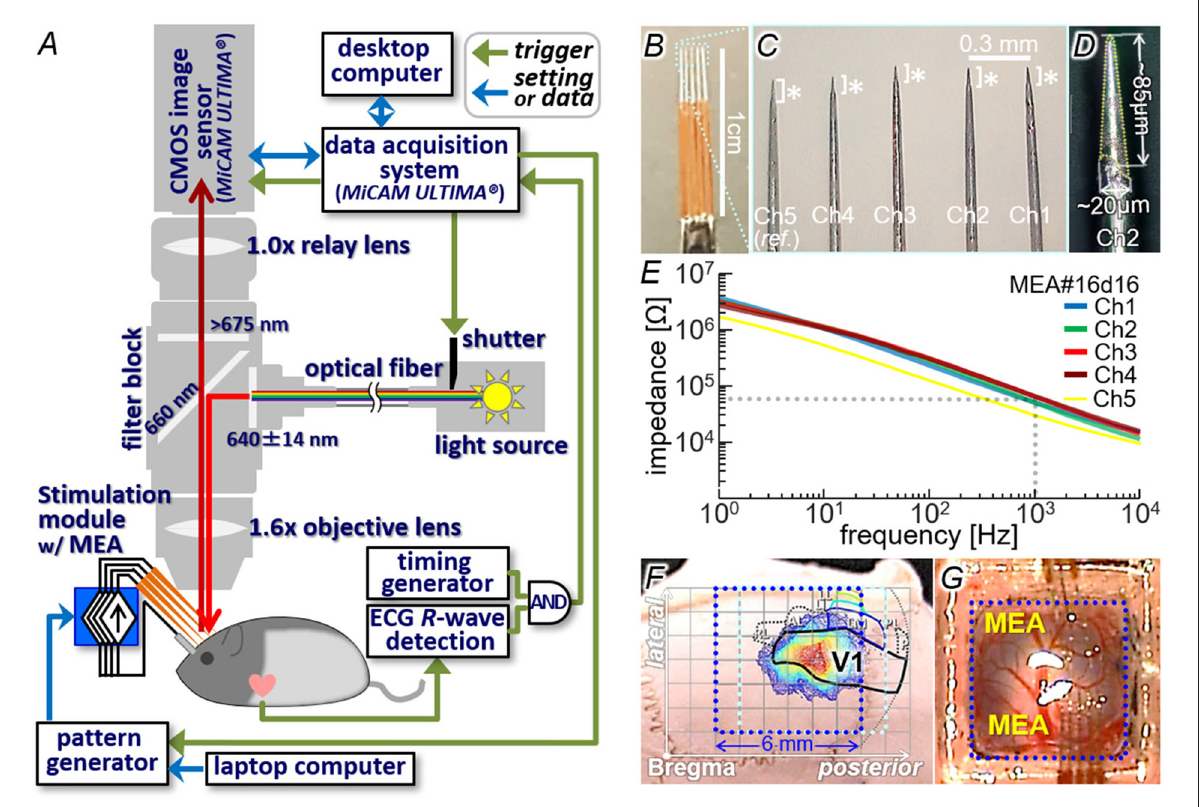
FIGURE4 Animal experiment setup. (A) Schematic diagram of the voltage-sensitive dye imaging system combined with the stimulation module. (B–D) An example of multi-electrode array ( MEA ) used for the intracortical stimulation. This MEA was used in the experiments shown in Figures 7–9. (E) Measured impedance profiles of five electrodes shown in (C) . (F) Location of the craniotomy on the skull with overlying the light-induced response profile and the visual cortices atlas. (G) Exposed cortex stained with VSD and two penetrating